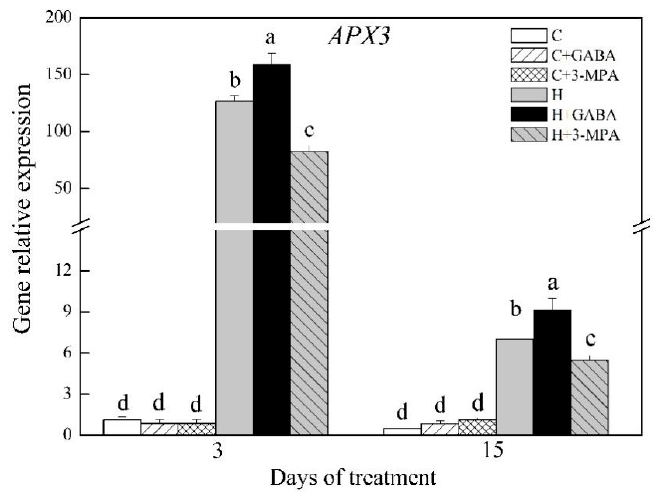
Figure 8. Effects of γ -aminobutyric acid (GABA) and 3-mercaptopropionic acid (3-MPA) on APX3 relative expression in leaves of creeping bentgrass at 3 and 15 d of 23/18 (normal condition) or 38/33 °C (heat stress). Vertical bars above columns indicate ±standard error (SE) of means ( n = 4) and different letters above columns indicate significant differences ( p ≤ 0.05). C: control; C+GABA: control + GABA; C+3-MPA: control+3-MPA; H: heat; H+GABA: heat+GABA; H+3-MPA: heat+3-MPA.